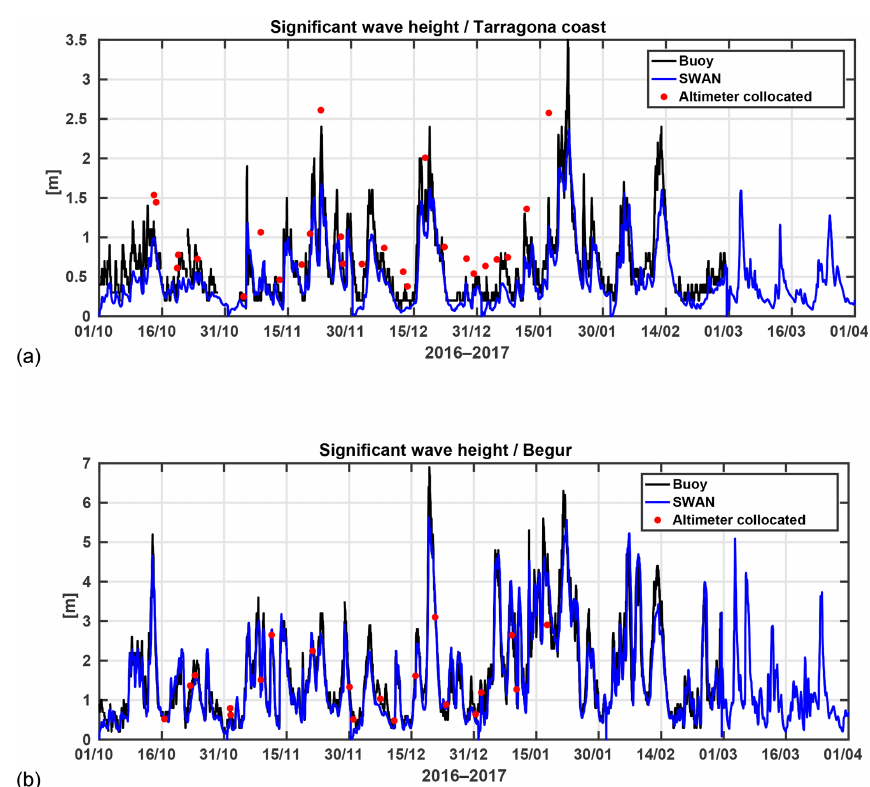
Figure 5. Comparison of numerically simulated significant wave height (SWAN model) with observations for (a) south sector (Tarragona location) and (b) north sector (Begur location) for the period October 2016 to March 2017. The red dots are altimeter data (Jason-2, Jason-3 and